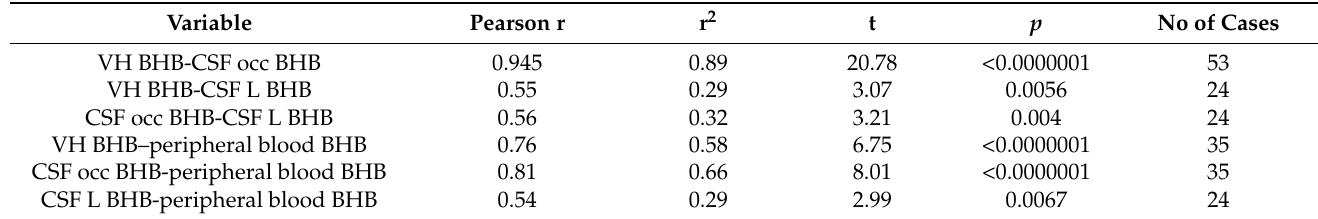
Table 4. Correlations between VH BHB, CSF occ BHB, CSF L BHB and peripheral blood BHB.